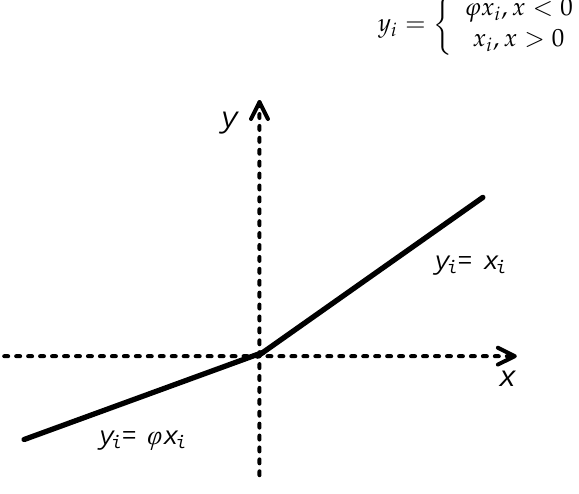
Figure 5. The architecture of proposed convolutional block optimization.